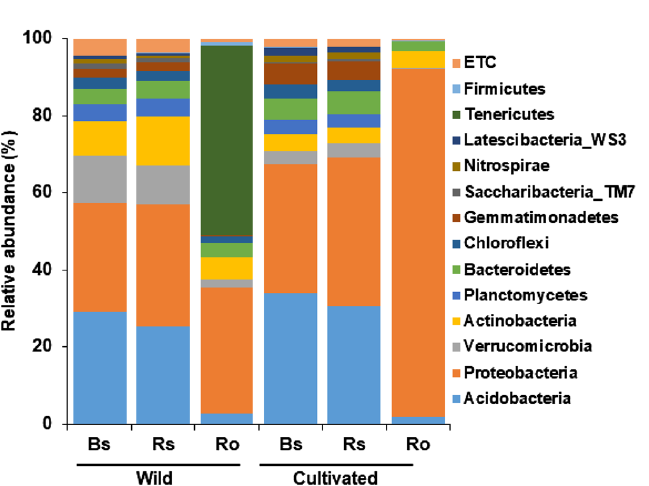
Figure 3. Comparative analysis of bacterial composition and relative abundance at the phylum level. The bulk soil (Bs), rhizosphere soil (Rs), and root (Ro) samples of Ulleung-sanmaneul plants collected from wild and cultivated areas. Phyla with relative abundances more than 1% in at least one compartment were selected and compared. Phyla with relative abundances less than 1% were referred to as